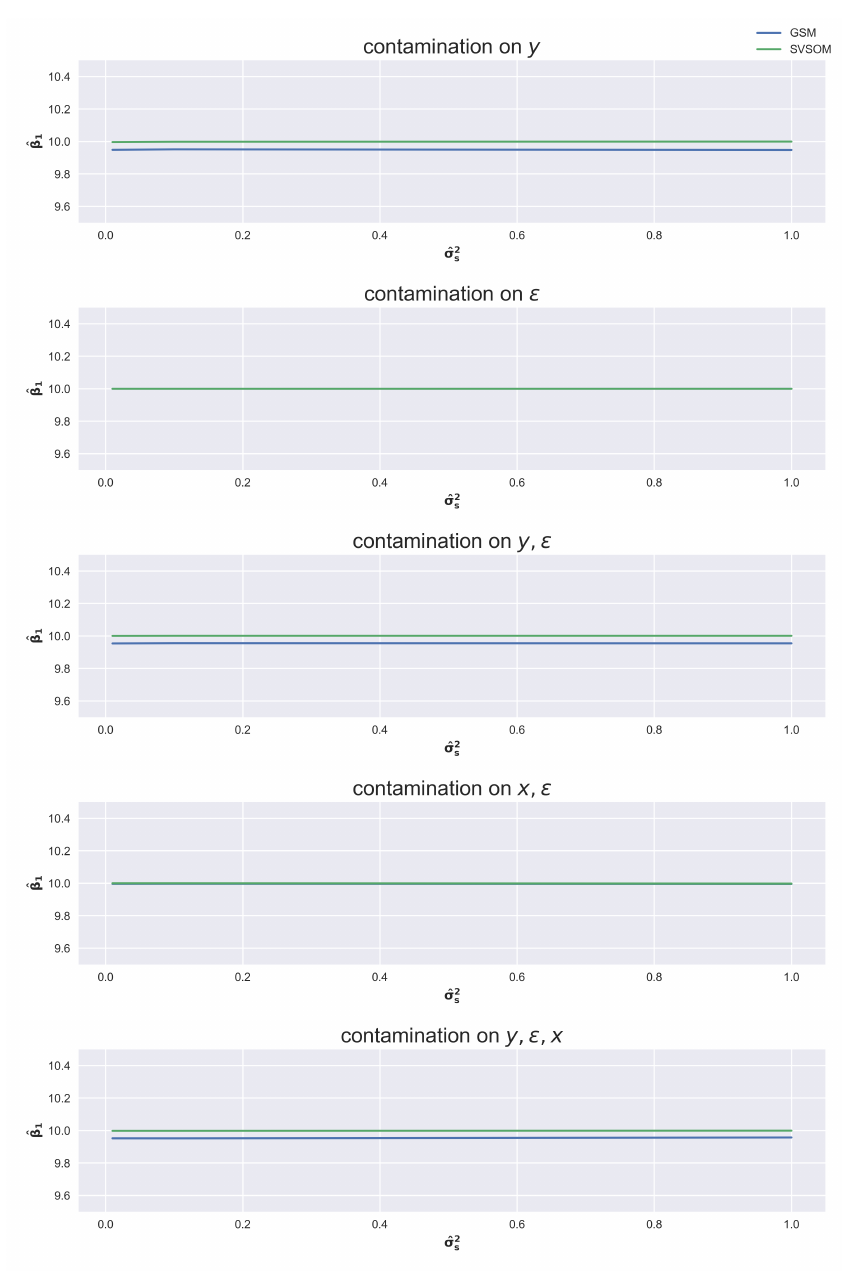
Figure 2. The graph of ˆ σ 2 s against ˆ β 1 for ρ = 0.7 and λ = 0.8 from different sources of